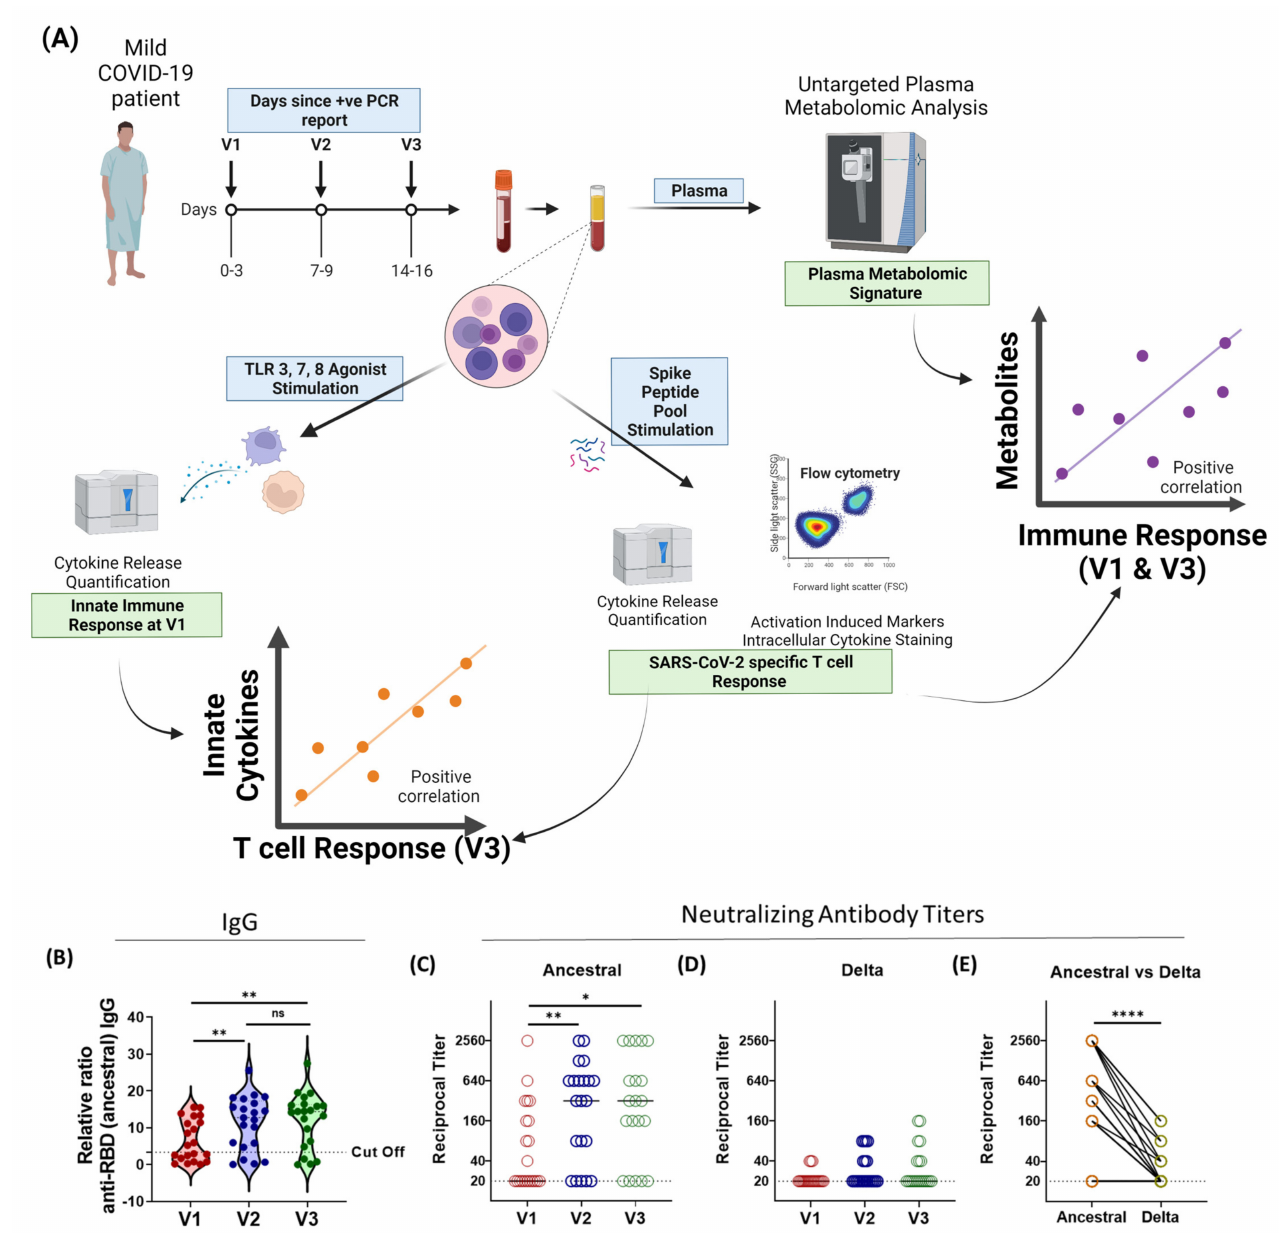
Figure 1. Longitudinal analysis of humoral immune response against the SARS-CoV-2 during acute COVID-19 infection. ( A ) Graphical representation of the study plan. ( B ) The longitudinal anti-RBD IgG responses were evaluated by performing ELISA against the RBD proteins of the ancestral (Wuhan isolate) strain. All data, represented as ratio-converted ELISA reads to a pool of pre-pandemic negative control samples (relative ratio), were plotted using violin plots. ( C – E ) The longitudinal neutralizing antibody titers against ( C ) the ancestral strain and ( D ) the delta strain of SARS-CoV- 2 during V1 (day 0–3), V2 (day 7), and V3 (day 14) from COVID-19 positivity. ( E ) The paired representation of NAb titers in the active COVID-19 patients during V3 against the ancestral and delta variants of SARS-CoV-2. ns not significant * p < 0.05, ** p ≤ 0.01, **** p <